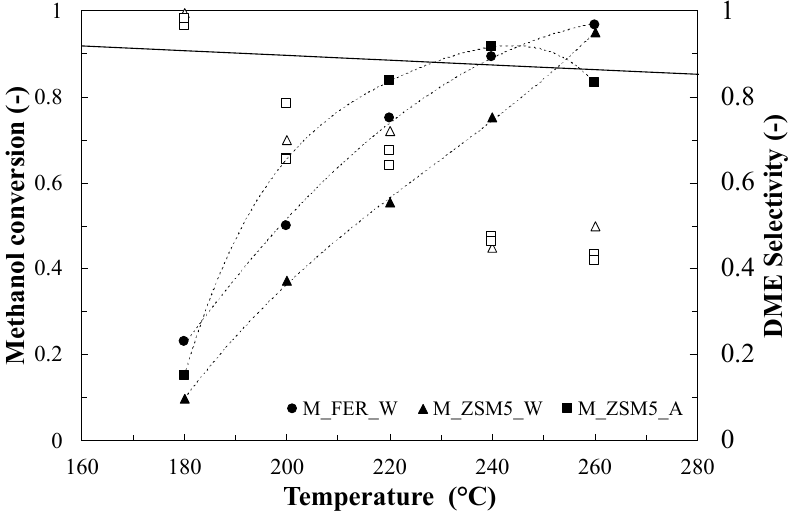
Figure 3. Methanol conversion closed symbols and DME selectivity (open symbols) for hybrid samples. Test conditions: Methanol = 5.6%; Carrier flow rate (N2) = 60 NmL / min; WHSV = 4.5 h − 1